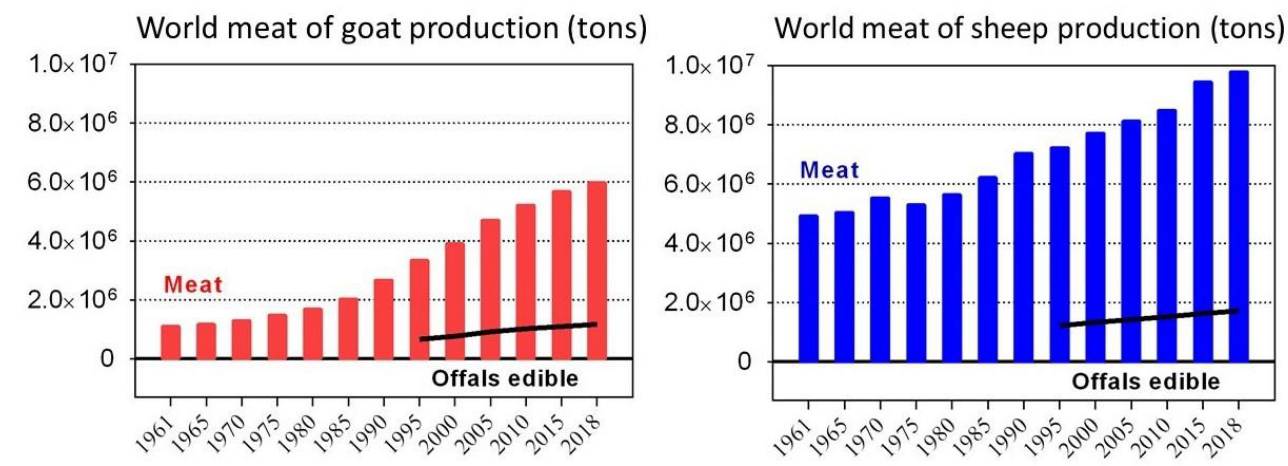
Figure 1. World production of edible meat and meat by-products.